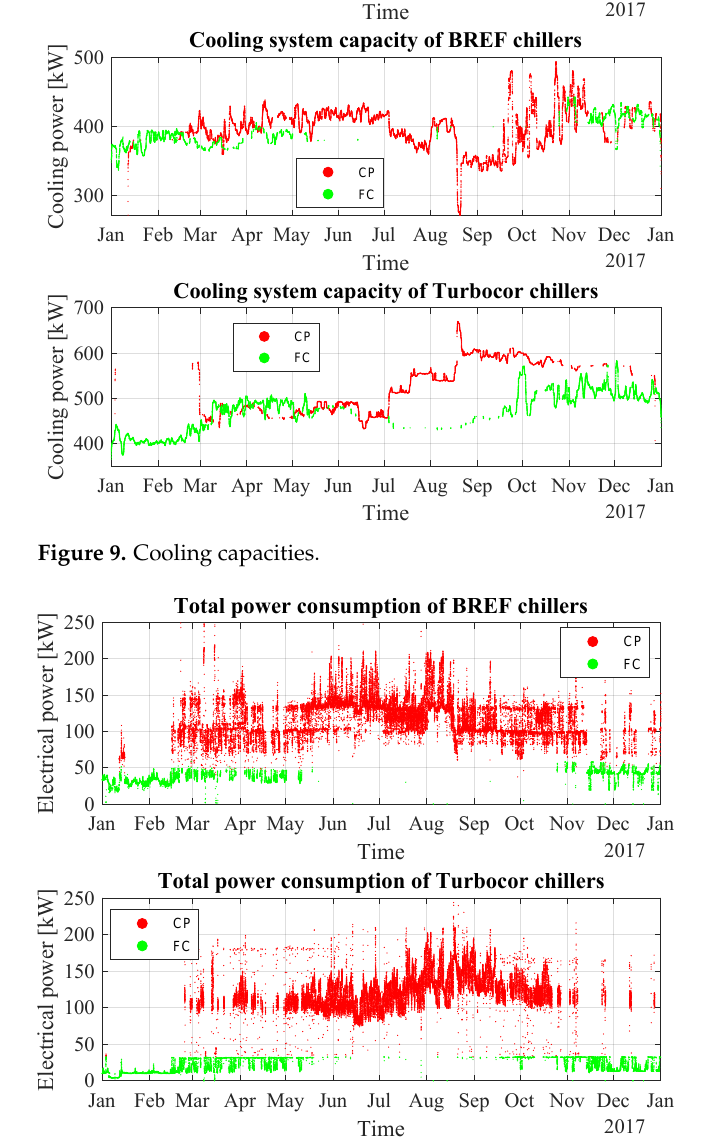
Figure 10. Electrical power